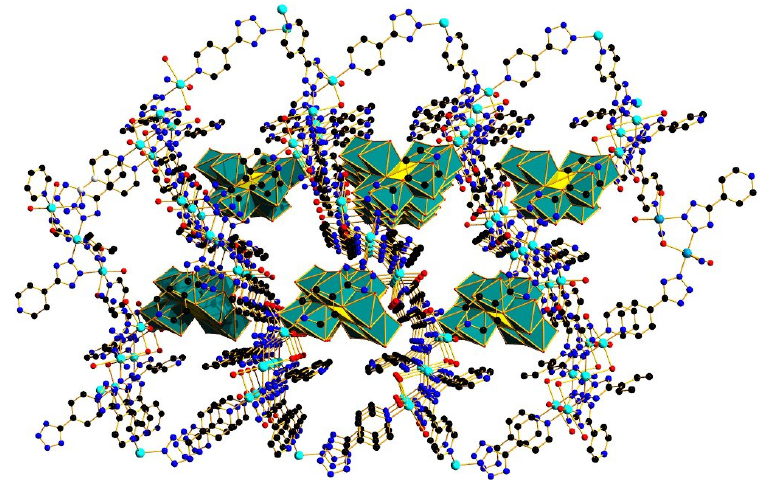
Figure 9. Representation of (en)[Cu 3 (ptz) 4 (H 2 O) 4 ][Co 2 Mo 10 H 4 O 38 ] compound. 3D host–guest framework (ball-and-stick) with two enantiomers of [Co 2 Mo 10 H 4 O 38 ] 6− (polyhedral representation) as the guest. (Colour scheme: Mo, teal; O, red; Cu, cyan; Co, yellow; C, black; N, blue; Lanthanide, pale yellow).